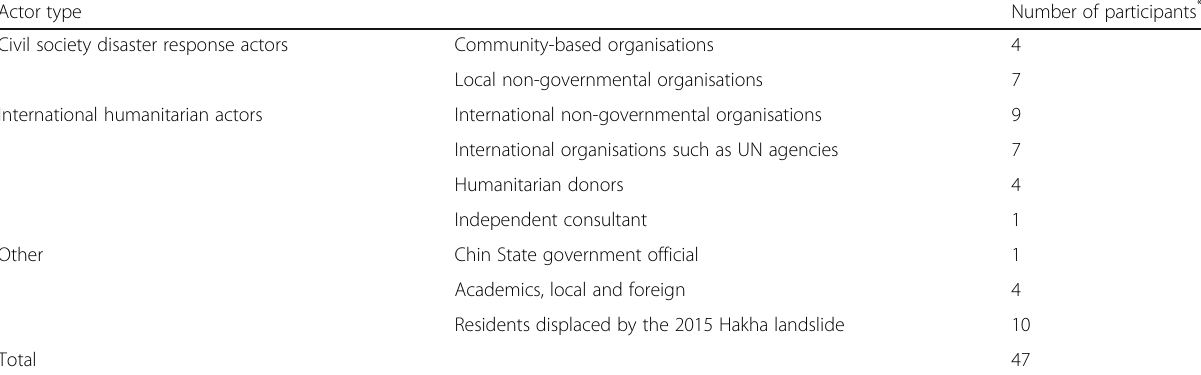
Table 1 Overview of interviewees and focus group participants Actor